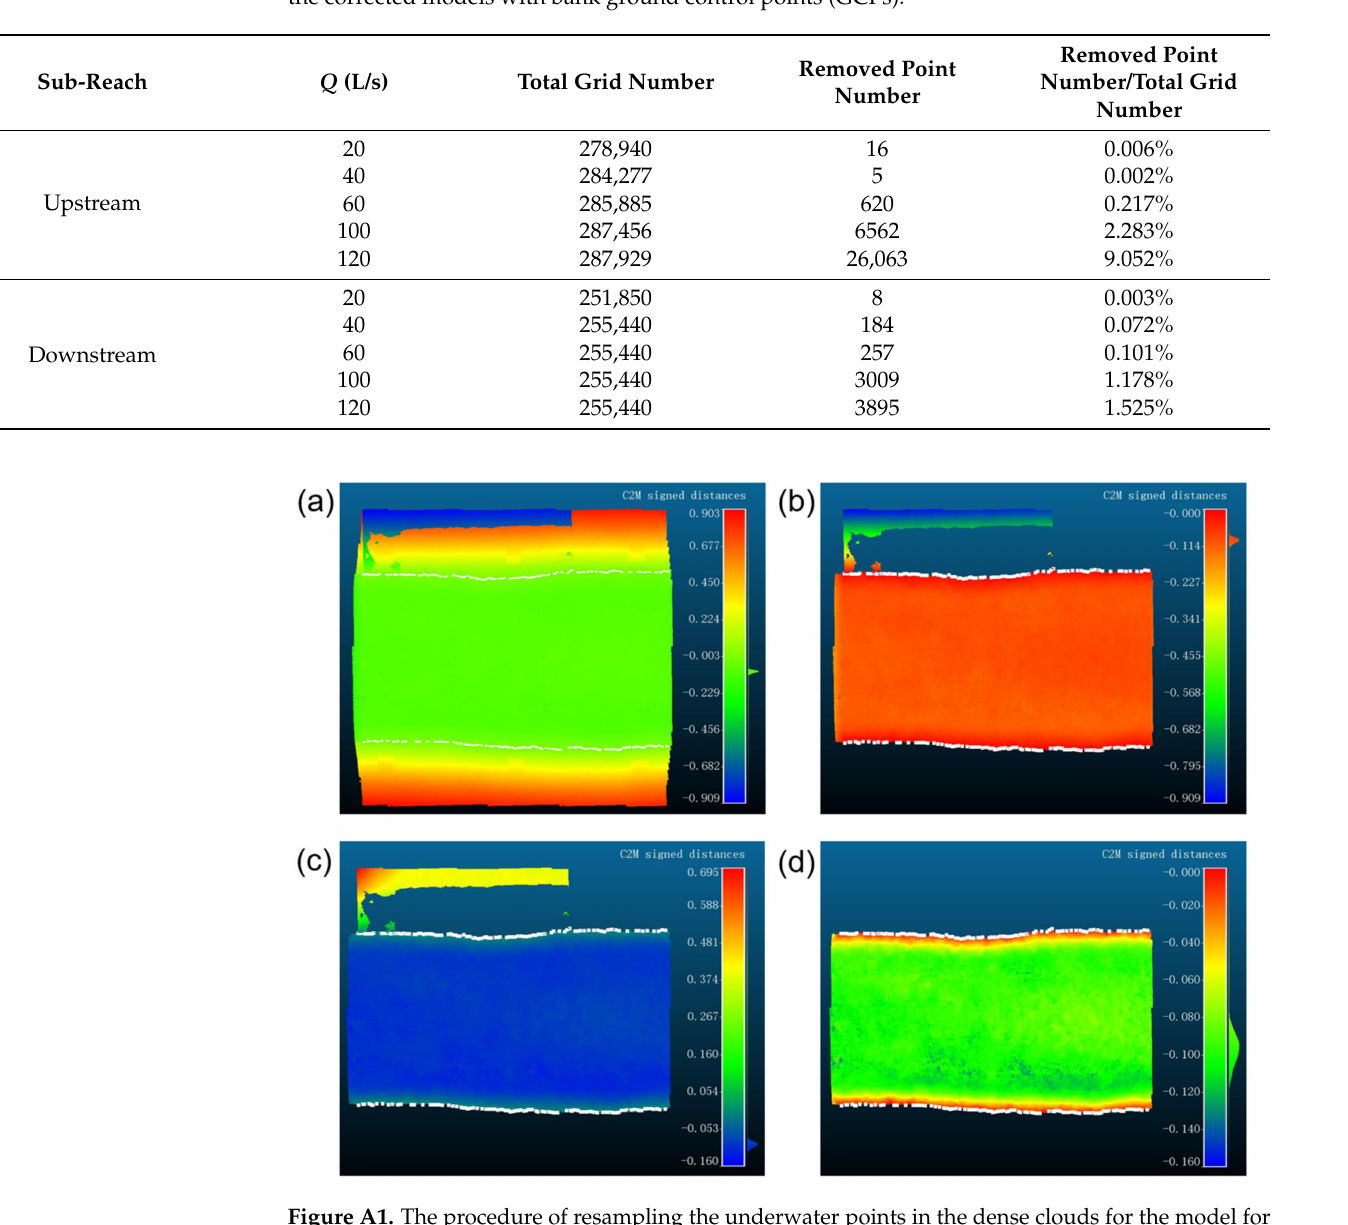
Table A2. Settings for the analyzed areas and data filtering to remove the distinct errors < − 0.02 m in the corrected models with bank ground control points (GCPs).